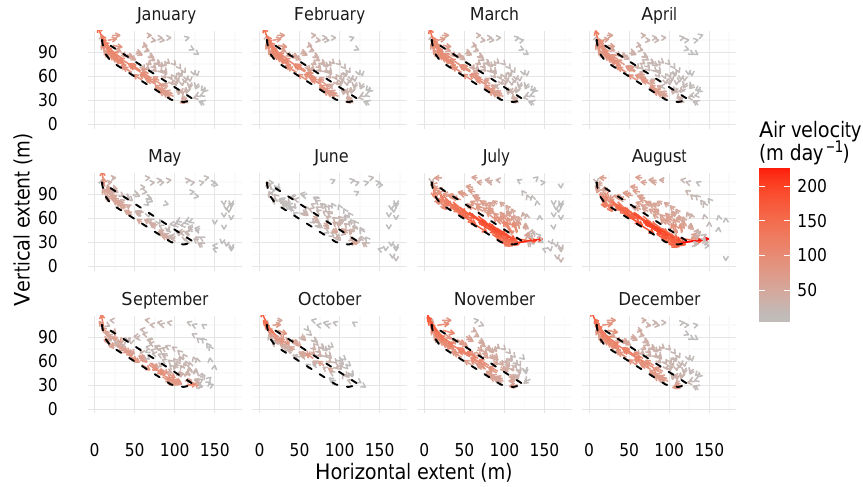
Figure 4. Mean monthly air flow of the open experiment (OPE) over the 13 modelled years. The dashed line marks the domain of the talus slope. The seasonal differences in intensity and direction of the air circulation are clearly shown by the direction and colour of the